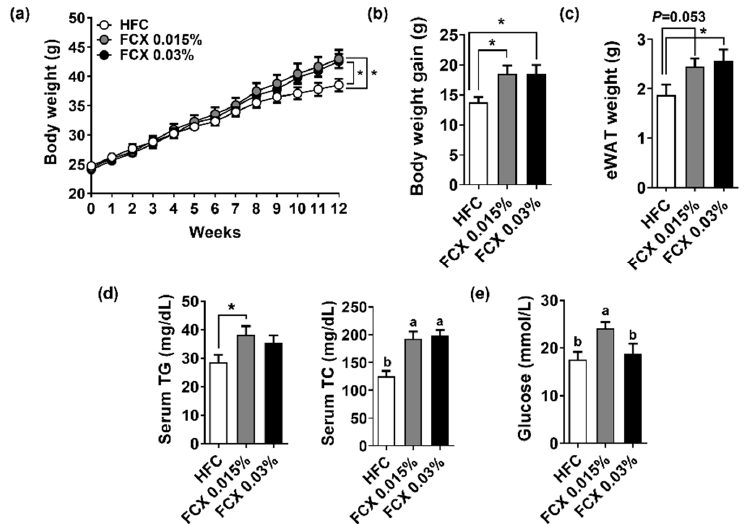
Figure 1. Effect of FCX on body and tissue weight changes and serum levels of lipids and glucose in DIO mice fed HFC control, FCX 0.015%, or FCX 0.03% diet for 12 weeks. ( a ) Body weight change throughout the 12 weeks of the experiment diet. ( b ) Body weight gain. ( c ) eWAT weight. ( d ) Serum TG and TC concentrations. ( e ) Serum fasting glucose levels. n = 8–11 per group. Mean ± SEM. Bars without sharing the same letter are significantly different ( p < 0.05). * p < 0.05 between two groups.